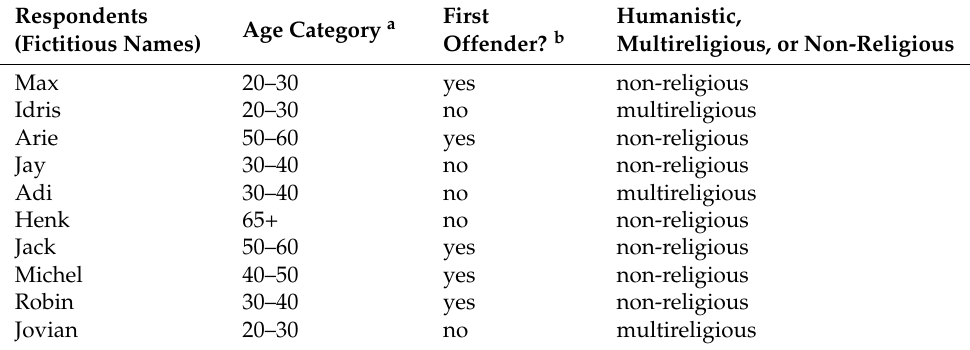
Table 1. Overview of the